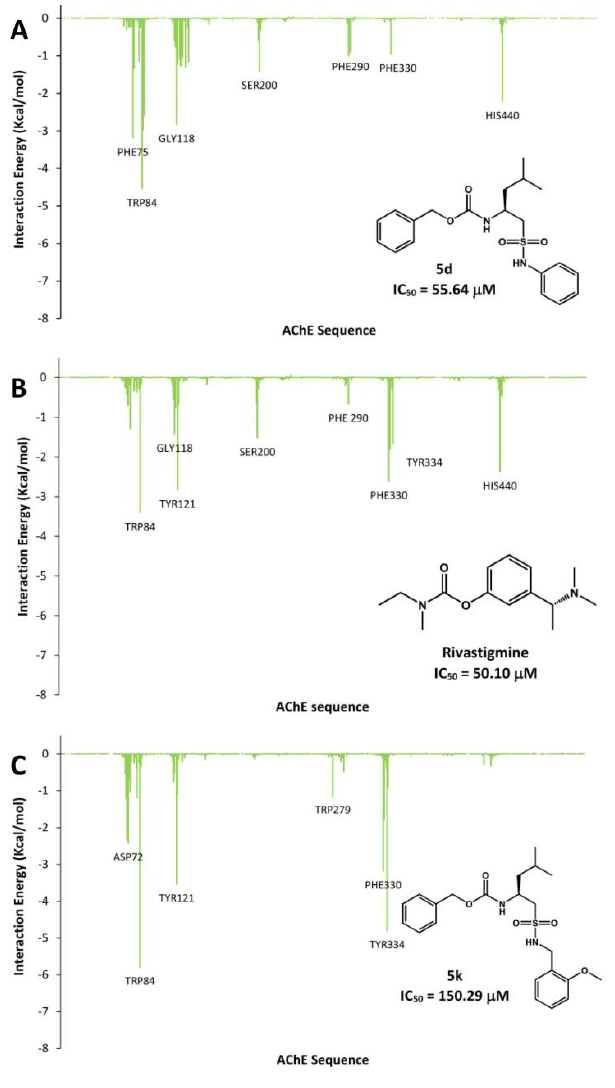
Figure 6. Histogram of interaction energies partitioned with respect to AChE amino acid sequence when complexed with compound 5d ( A ), RIV ( B ), and compound 5k ( C ). The X-axis denotes the residue number of BChE, and the Y-axis denotes the interaction energy between the compound and a specific residue. Negative and positive values are favorable or unfavorable for binding, respec- tively.